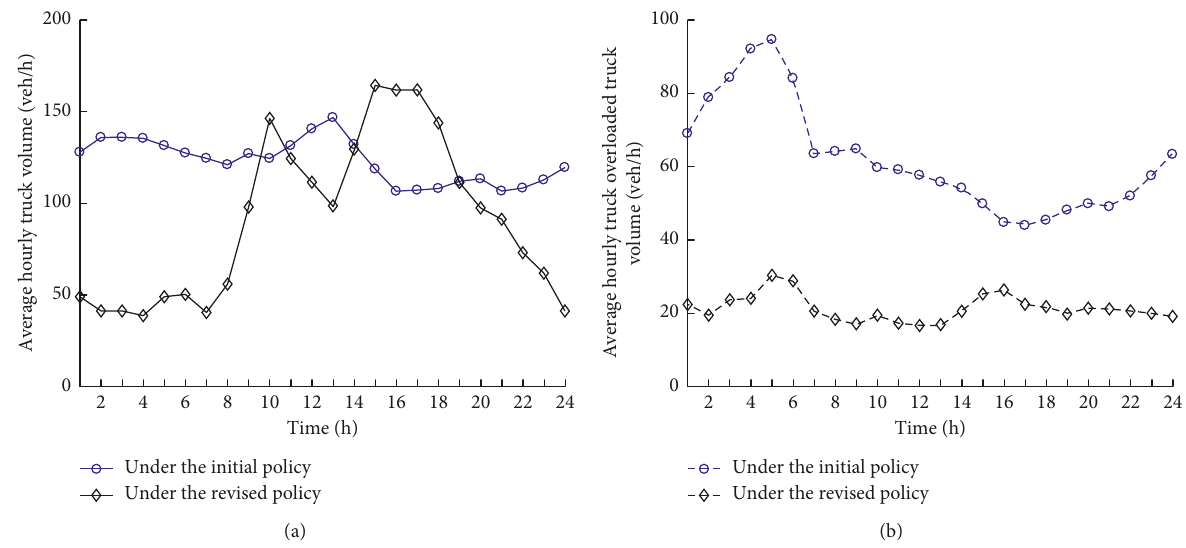
Figure 5: Truck volume distribution throughout the day under the initial and revised toll-by-weight policies with (a) hourly truck volume and (b) hourly overloaded truck volume. Table 7: Truck traffic characteristics and composition under the initial and revised toll-by-weight policies. Truck